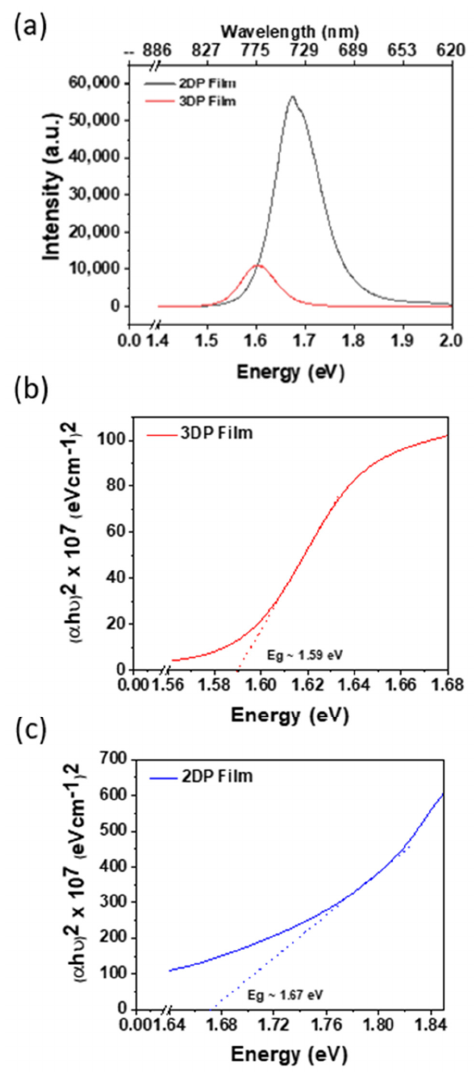
Figure 3. ( a ) The steady state PL spectra for our 2DP and 3DP films deposited directly on unetched FTO/glass substrates, which shows a peak emission occurring at 1.60 eV for the 3DP film and a peak position occurring at 1.67 eV for the 2DP photoabsorber. From the absorbance data measured using UV-Vis optical absorption spectroscopy, the optical bandgap E g was determined using the Tauc approach for the ( b ) 3DP film, and the ( c ) 2DP film, where E g was determined to be ~1.59 eV and 1.67 eV, respectively; these results were largely in alignment with the PL emission